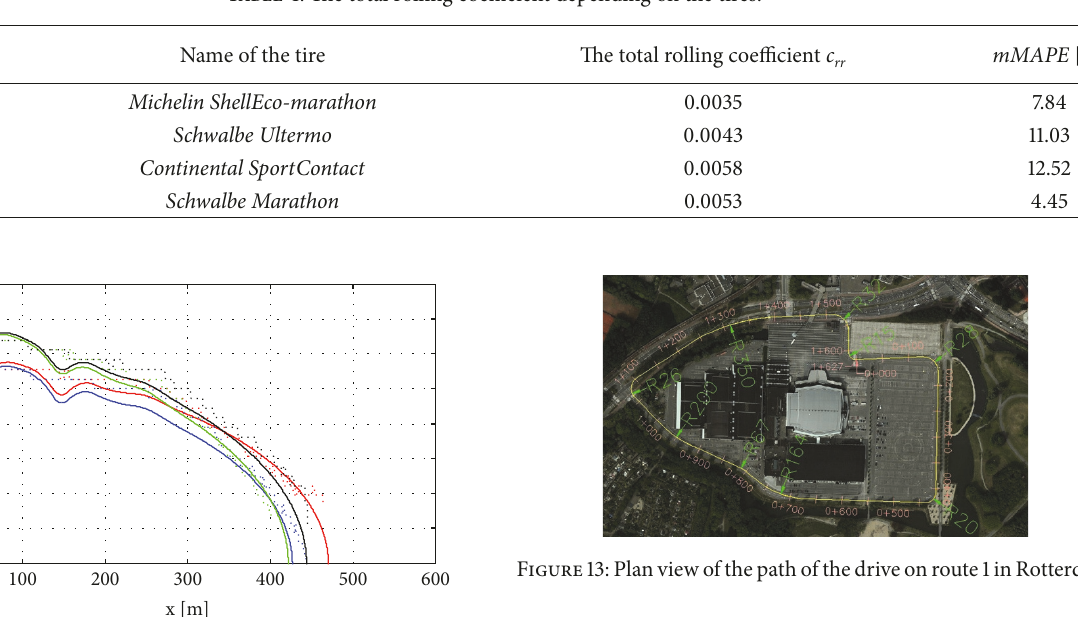
Table 4: The total rolling coefficient depending on the tires.